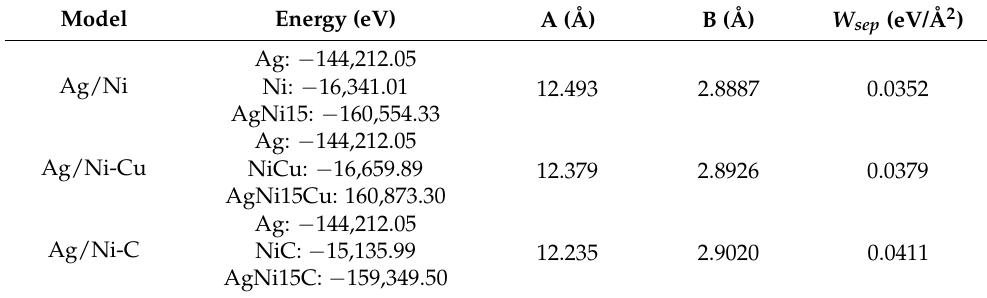
Table 2. The work of interfacial separation.